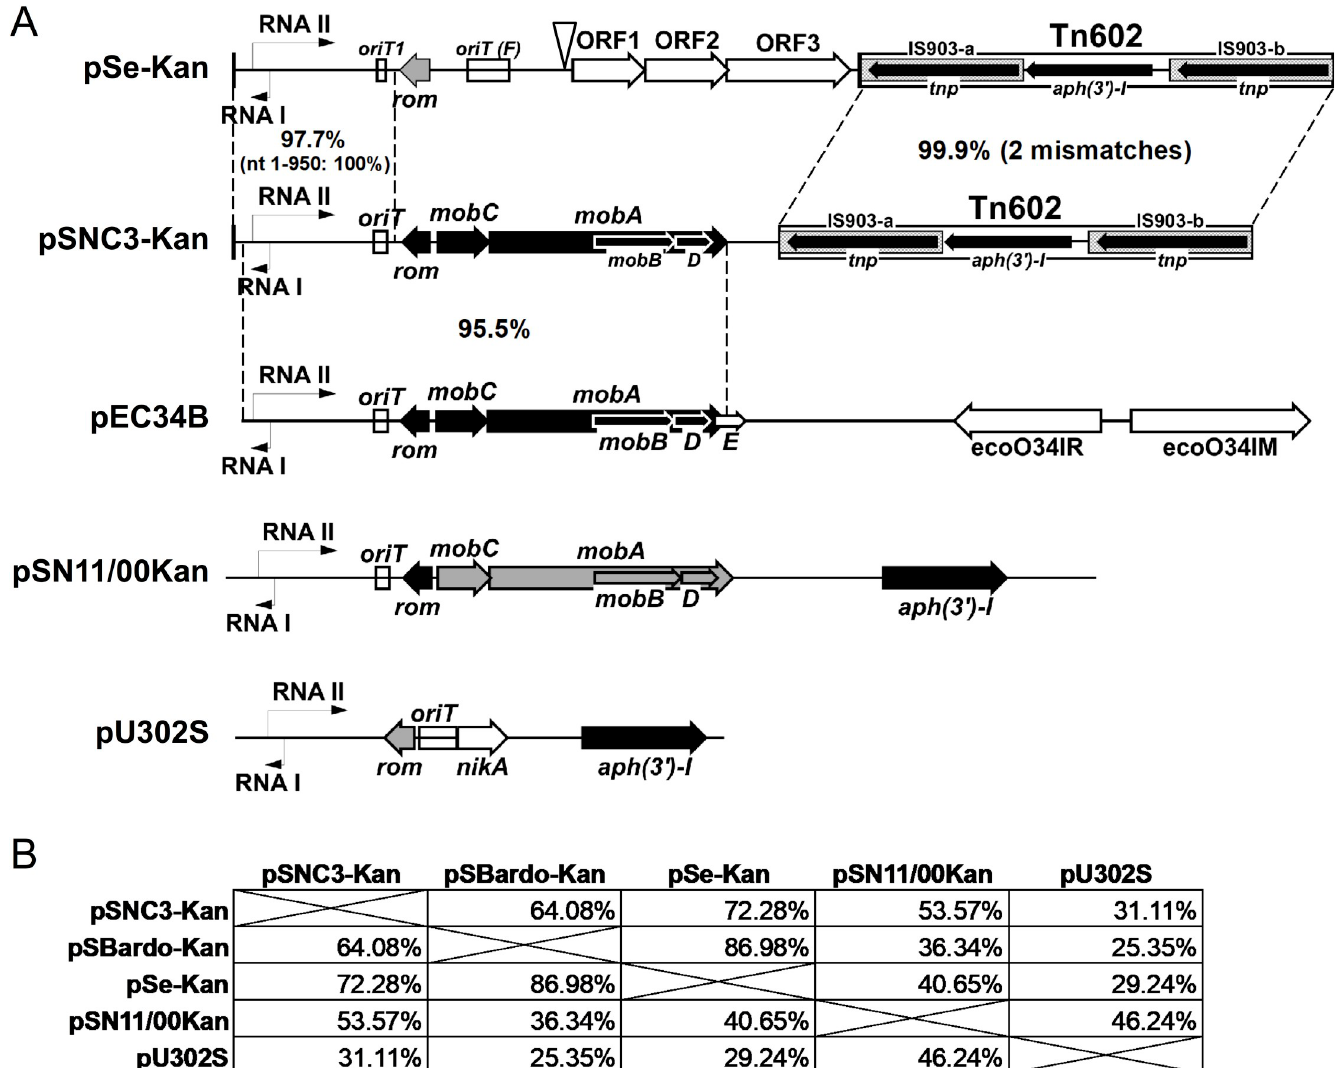
Fig 1. KanR plasmid maps and comparisons. (A) Schematic comparison of pSNC3-Kan to pSe-Kan and pEC34B. Plasmid regions sharing homologies with pSNC3-Kan are connected by dashed lines and the % nucleotide identity indicated. Maps of pU302S and pSN11/00Kan are also included. RNA I/II are indicated by thin lines with an arrow head; oriT regions are indicated by open boxes; IS elements are shown as patterned boxes with an internal arrow indicating the tnp ORF; target site duplications are shown as thick vertical line bordering the Tn 602 on pSe-Kan. Position of the extra IS903 copy on pSBardo-Kan is indicated by an upside-down triangle on pSe-Kan plasmid. Open reading frames are marked by thick arrows; black, > 90% protein identity to those of pSNC3-Kan; grey, < 90% identity to those of pSNC3-Kan; white, no homologs on pSNC3-Kan. (B) Pairwise percent identity of KanR